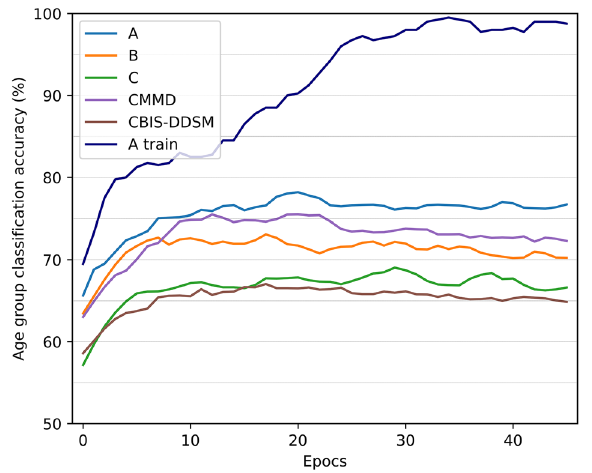
Figure 4. Smoothed, mean training schedule over 5 runs. Resnet50 trained on 1000 A images per class (under vs over 58 years). 150 images for each testing class from each dataset. This illustrates the clear generalization gap between A test I.I.D test sets and all other O.O.D test sets. A 5–10% drop in accuracy on test images that visually similar illustrates that PIP variation is a large contributing factor of domain shift. See supplementary Fig. S2. for examples with other Resnet networks each with similar results.